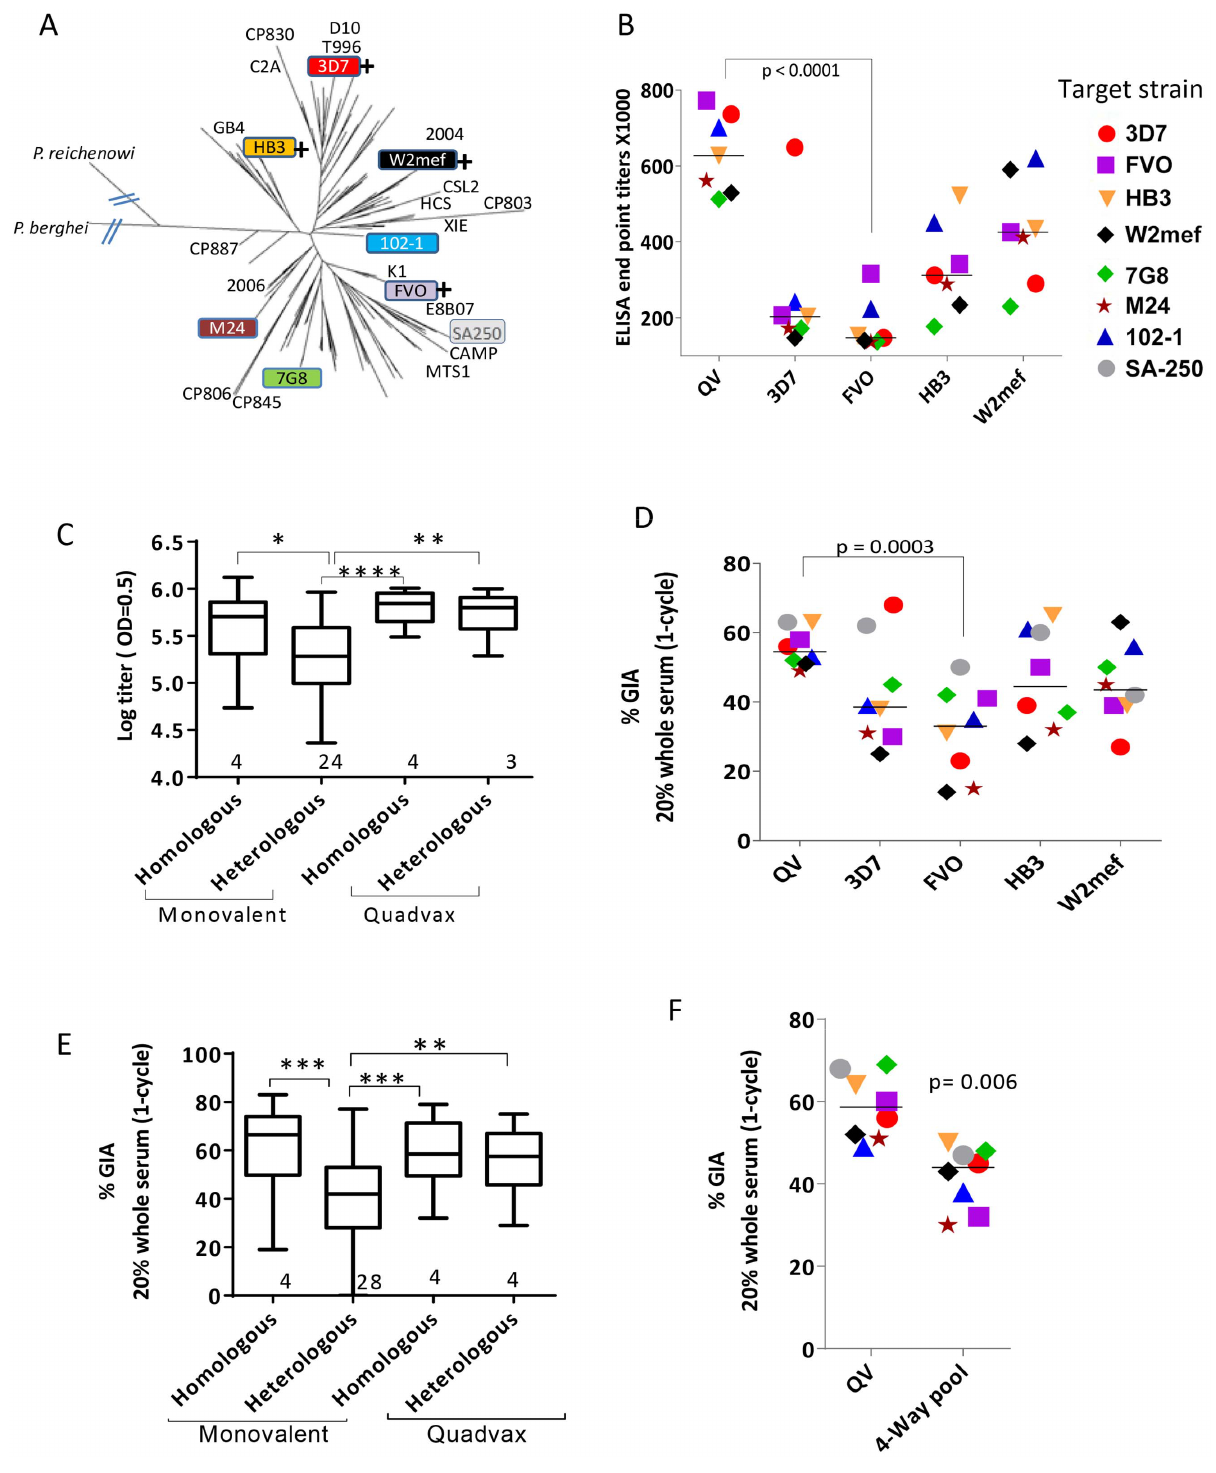
Figure 1. AMA1 sequence diversity and allelic coverage of four monovalent vaccines as compared to the QV. ( A ) A dendrogram constructed with full-length AMA1 sequences from the 26 target strains tested in GIA and 175 field strain sequences obtained from Genbank (Table S1). P. berghei (rodent) and P. reichenowi (chimpanzee) sequences were also included. ( + ) indicates that this allelic AMA1 protein was included in QV. The colored boxes were the 8 target strains used in the WRAIR GIA. ( B ) ELISA titers ( 6 1000) for the five vaccine groups tested against 7 allelic proteins. Symbols are mean of three rabbits and lines are median titer across strains. ( C ) Box-and-whiskers plot using individual rabbit ELISA data grouped on the basis of whether the coat antigen-antisera combinations were homologous or heterologous and whether monovalent or QV rabbits were tested. The number under each box represents the total number of protein-antisera combinations included. (*) indicates, p , 0.01, (**) p , 0.001, (***) p , 0.0001 and (****) p , 0.0001 for ANOVA followed by Tukey’s multiple comparisons test. ( D ) One-cycle GIA of the five vaccine groups against four non-vaccine and four vaccine strains using 1:5 whole serum dilution. Symbols in Fig. 1B and 1D and 1F are matched, except strain SA250 that